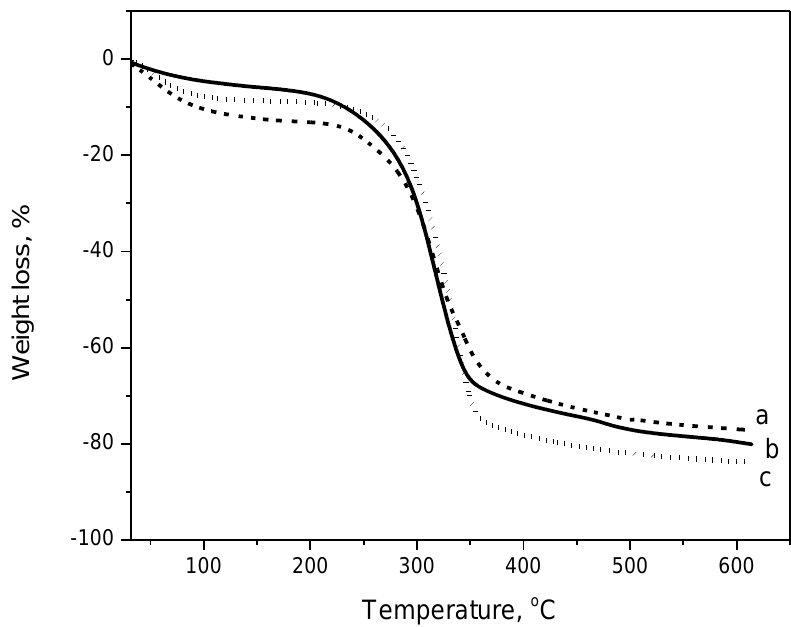
Figure 4. Thermogravimetric (TG) curve of ( a ) raw CP, ( b ) CNF procedure I, and ( c ) CNF procedure II.